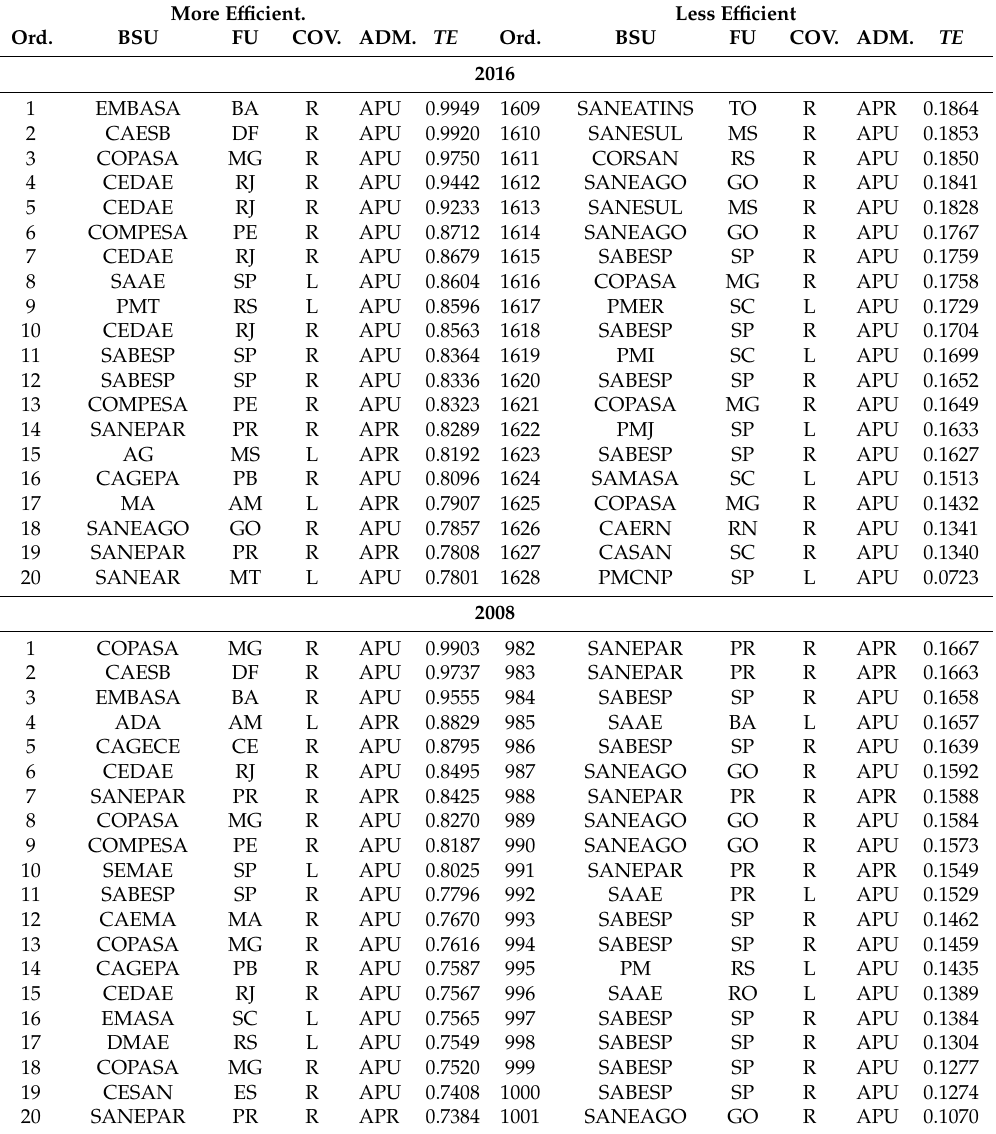
Table A1. E ffi ciency scores of the 20 basic sanitation companies with the best and worst results (ordered in descending order). More E ffi cient. Less E ffi cient